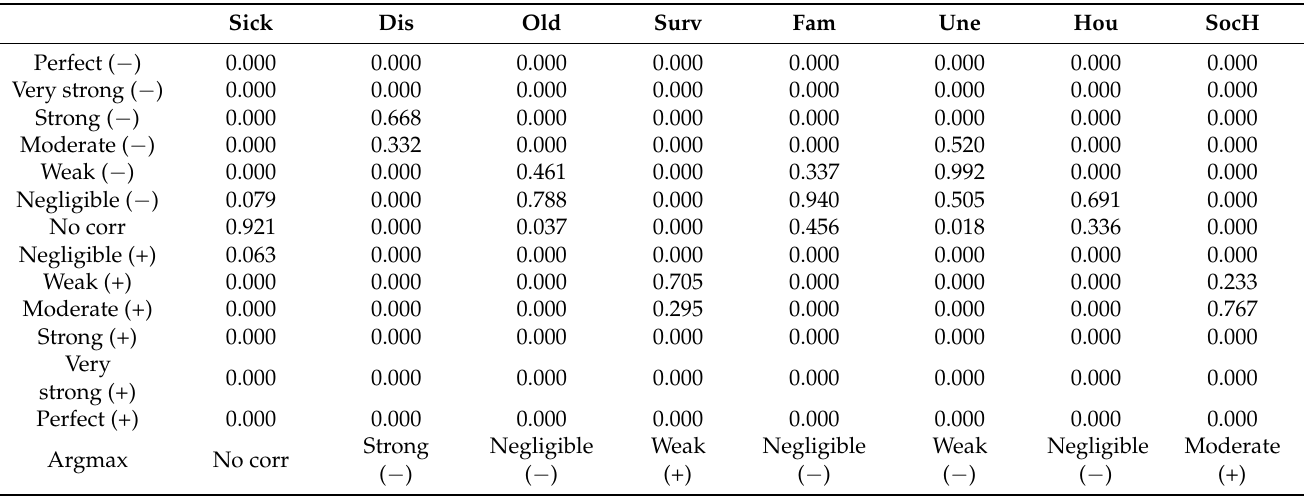
Table 14b. Value of the compatibility indexes (7b) of the correlations between DF and the proportion that each kind of social expense suppose in overall SE and the labels of the linguistic variable “correlation coefficient” (Non-EU-15 countries).